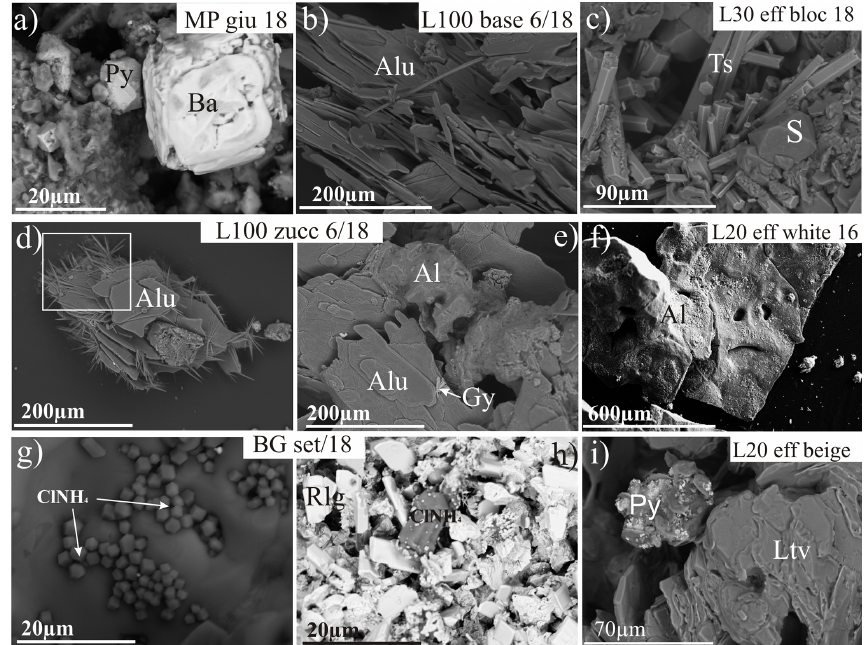
Figure 3. BSEM image showing sample texture and occurrences of S-bearing phases identified by EDS and XRDP analyses at the Puteoli sulfate lands: (a) orthorhombic barite (Ba) front of pentagonal pyrite (Py) from the Pisciarelli mud (L3); (b) irregular platy alunogen (Alu) oriented parallel to the fracture axis; (c) rhombic native sulfur (S) with bladed tschermigite crystals (Ts); (d) acicular alunogen (Alu) crystals developed above early tabular alunogen species; (e) euhedral alunite grains (Al) showing resorbed surfaces and coexisting with tabular alunogen (Alu) and acicular gypsum (Gy) crystals; (f) massive alunite (Al) encrustation; (g) pseudo-cubic ammonium chloride (ClNH 4 ) crystals within encrustation sampled at Bocca Grande (BG); (h) monoclinic realgar (Rlg) and ammonium chloride (ClNH) individuals at Bocca Grande (BG); (i) grains coated by pyrite and massive letovicite crystals. Alu – alunogen; Al – alunite; Ba – barite; ClNH 4 – ammonium chloride (salammoniac); Gy – gypsum; Ltv – letovicite; py – pyrite; Rlg – realgar; S – native S; Ts – tschermigite. Sample names as in Table S1. Refer to Fig. 1e for site